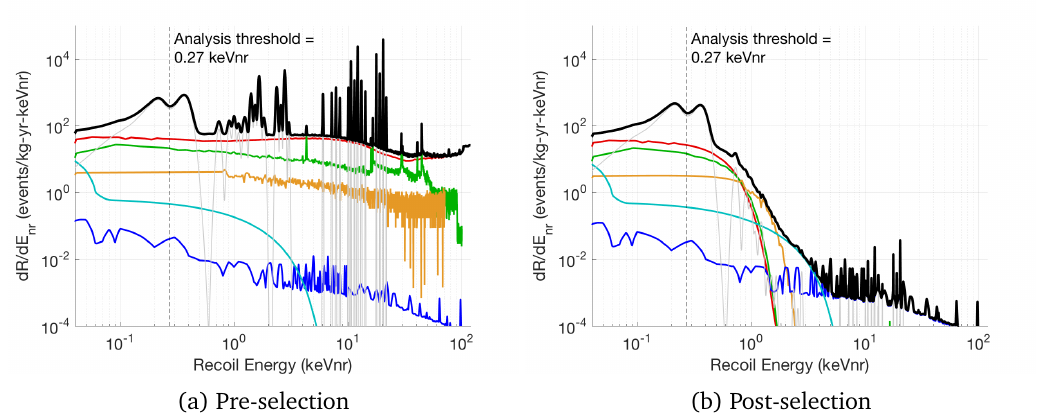
Figure 21: Figures from Ref. [ 29 ] . Background spectra, before (left) and after (right) analysis cuts in Germanium iZIP detectors, shown as a function of nuclear recoil en- ergy (keVnr) to allow direct comparison of the various backgrounds to the natural dark matter interaction energy scale. Thick black lines represent the total background rates. Electron recoils from Compton gamma-rays, 3 H and 32 Si are grouped together (red). The Ge activation lines (grey) are shown convolved with a 10 eV r.m.s. reso- lution. The remaining components are surface betas (green), surface 206 Pb recoils (orange), neutrons (blue) and neutrino interactions